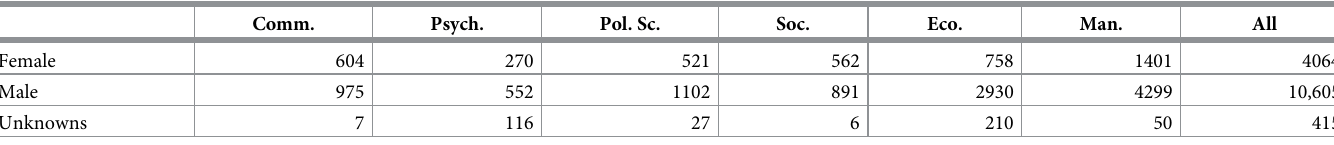
Table 4. Gender representation of EBs for each field and for the complete sample. Comm. Psych. Pol. Sc. Soc. Eco.